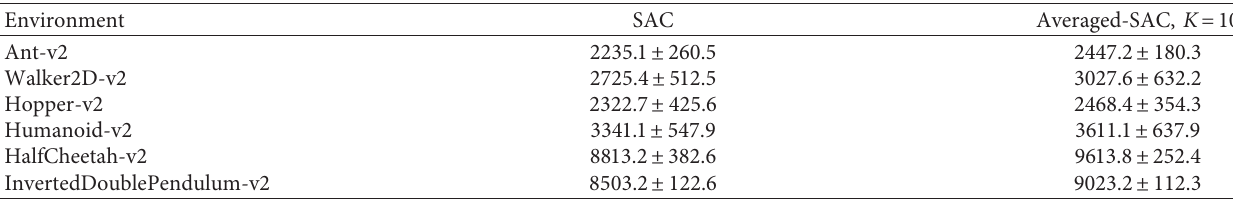
Table 1: The training scores of Averaged-SAC and SAC in 6 MuJoCo